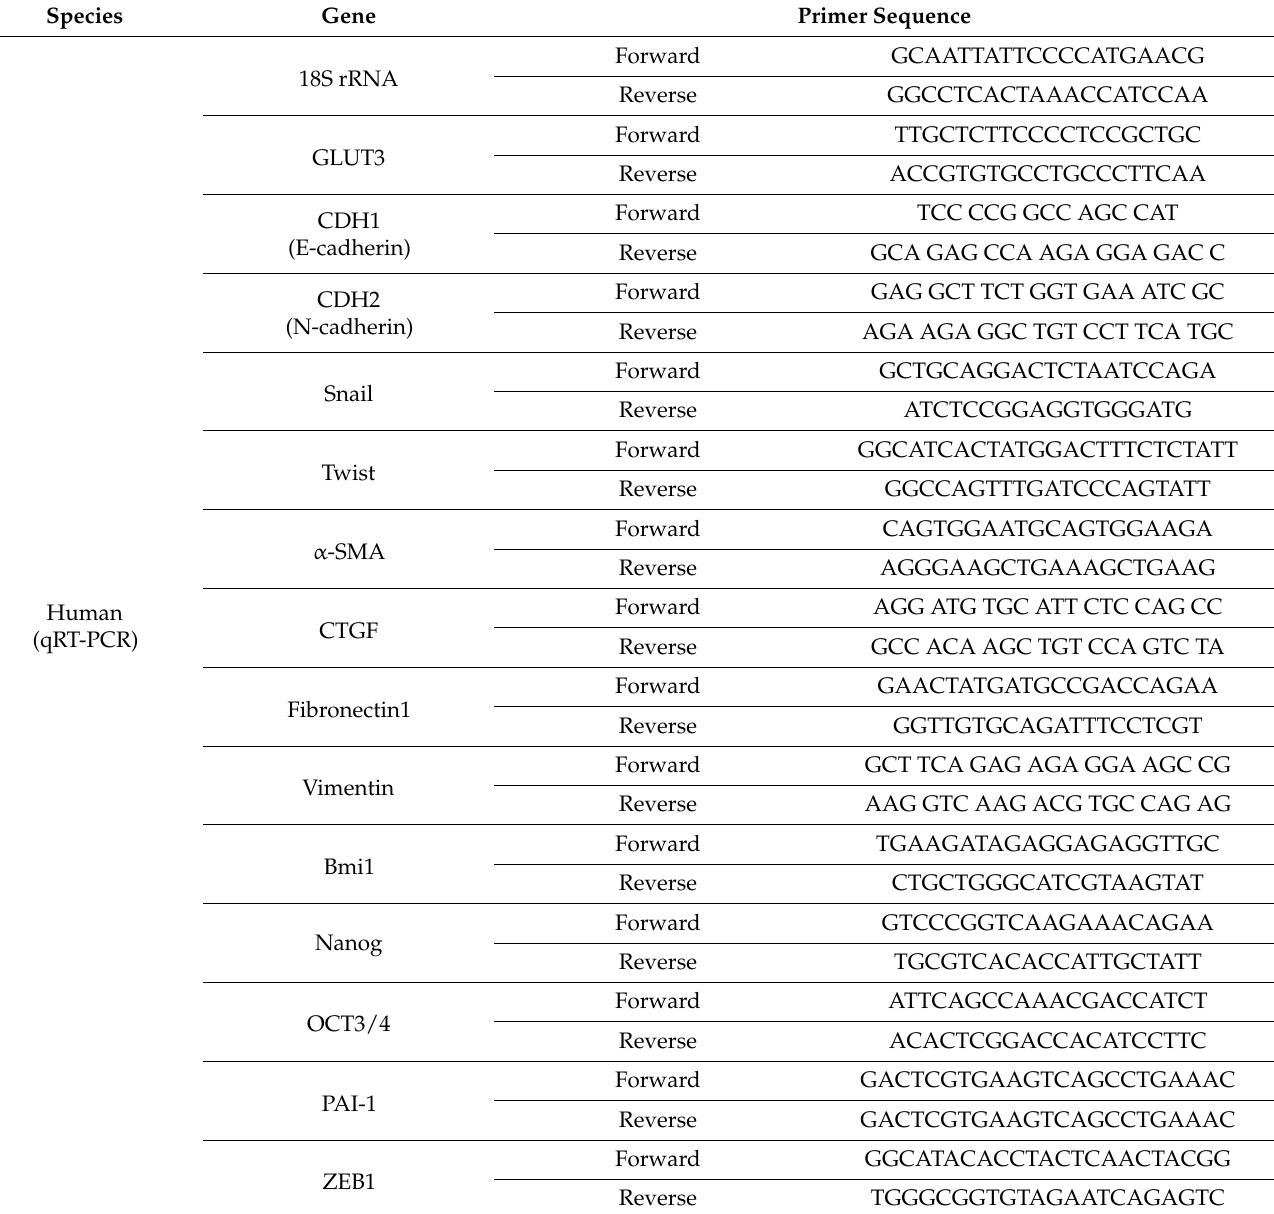
Table 1. Primer sequences used for